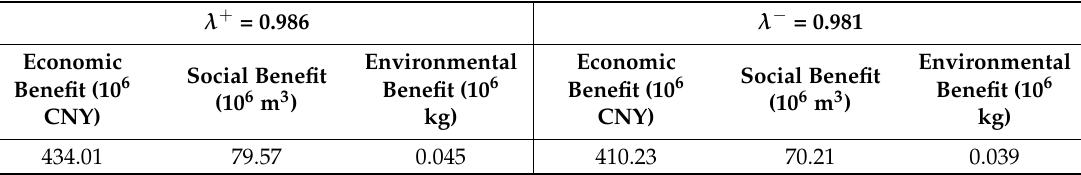
Table 3. Results of objective function